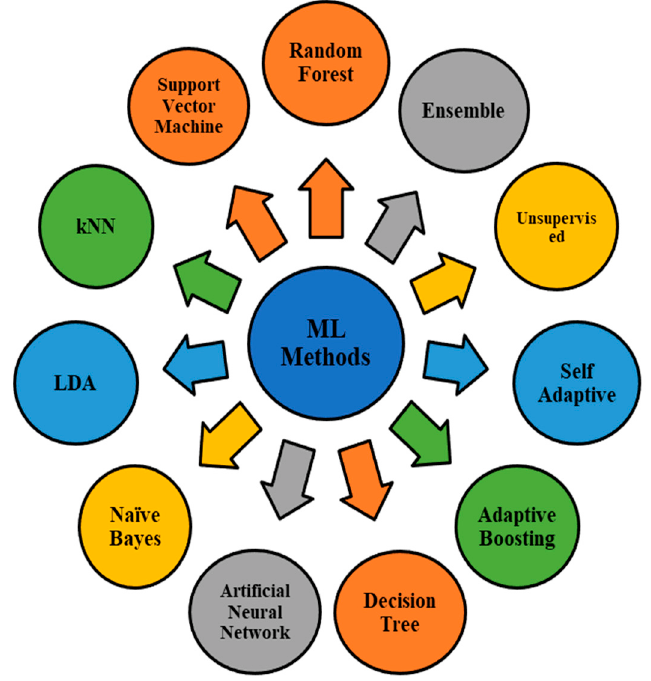
Figure 9. Machine learning methods.